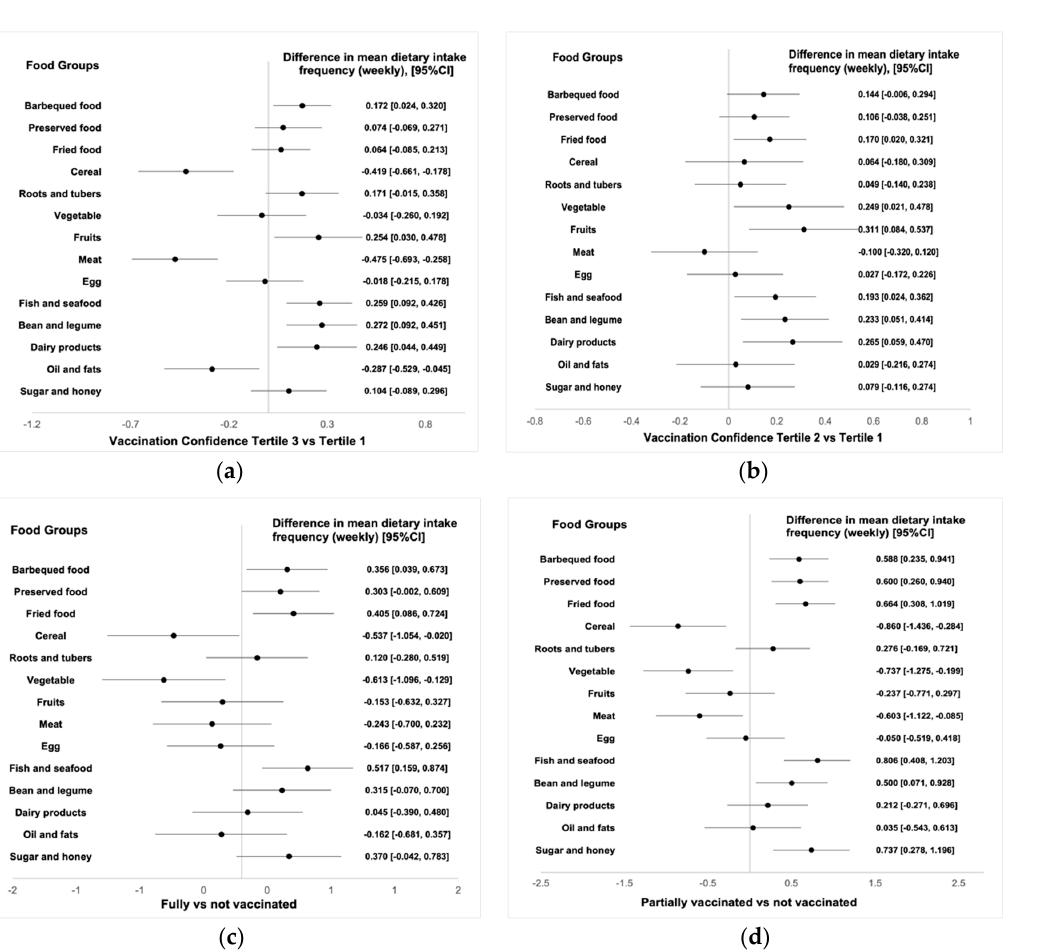
Figure 2. Dietary intake frequency by vaccination status and confidence tertiles. ( a – d ): difference in the mean weekly dietary intake frequency in the past month among four comparisons: Tertile 3 vs. Tertile 1 (vaccination confidence), Tertile 2 vs. Tertile 1 (vaccination confidence), fully vs. not vaccinated and partially vs. not vaccinated, respectively.